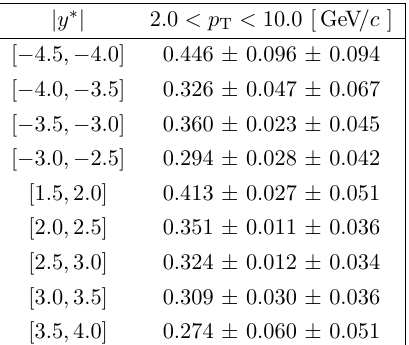
Table 8 . Production ratio R as a function of y (cid:3) for 2 < p T < 10 GeV =c . The (cid:12)rst uncertainty (cid:3) + c =D 0 is statistical and the second is